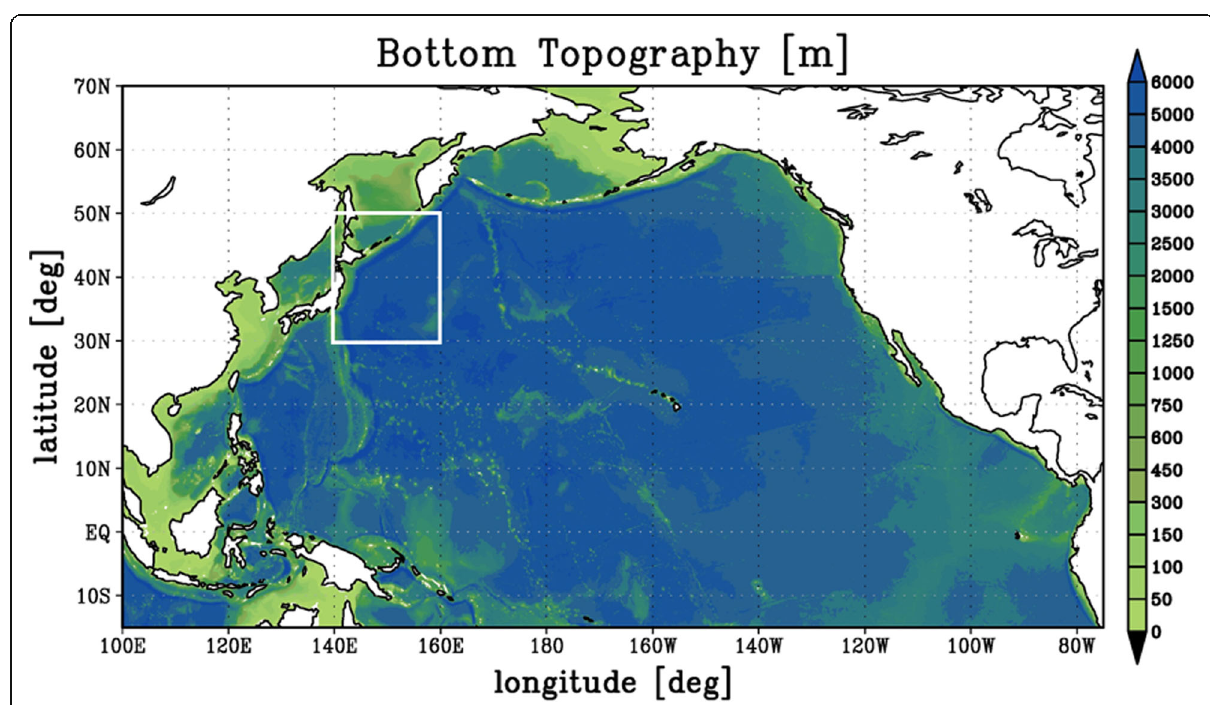
Fig. 2 Model domain of FORP-NP10 configuration. Color shades are bottom topography and overlaid white box is area of analysis in this